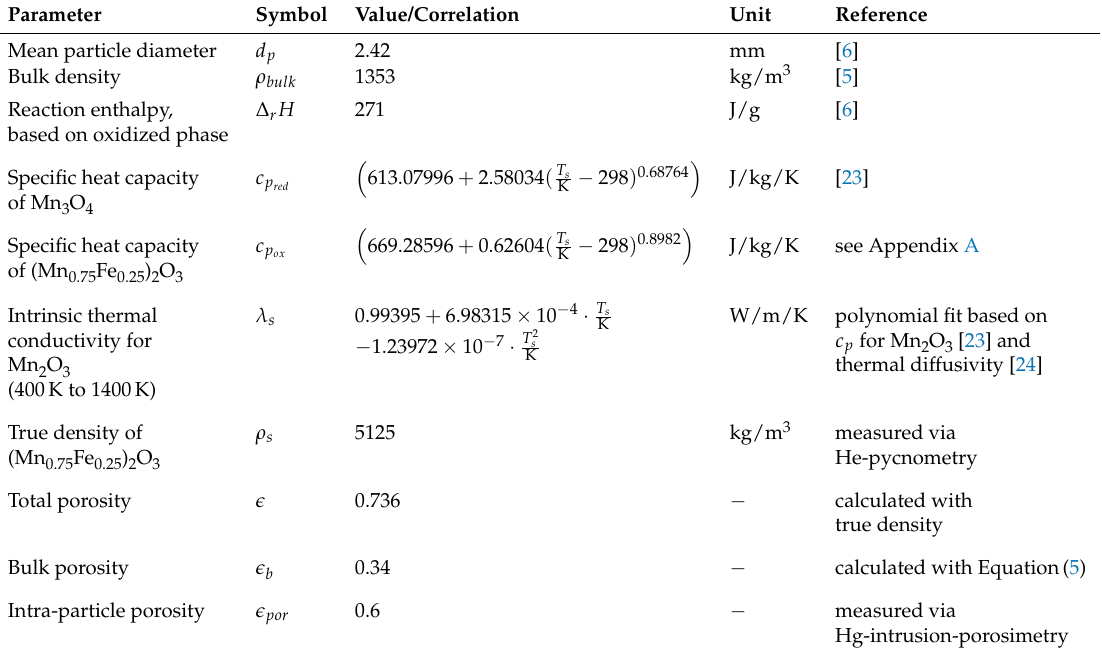
Table 1. Material